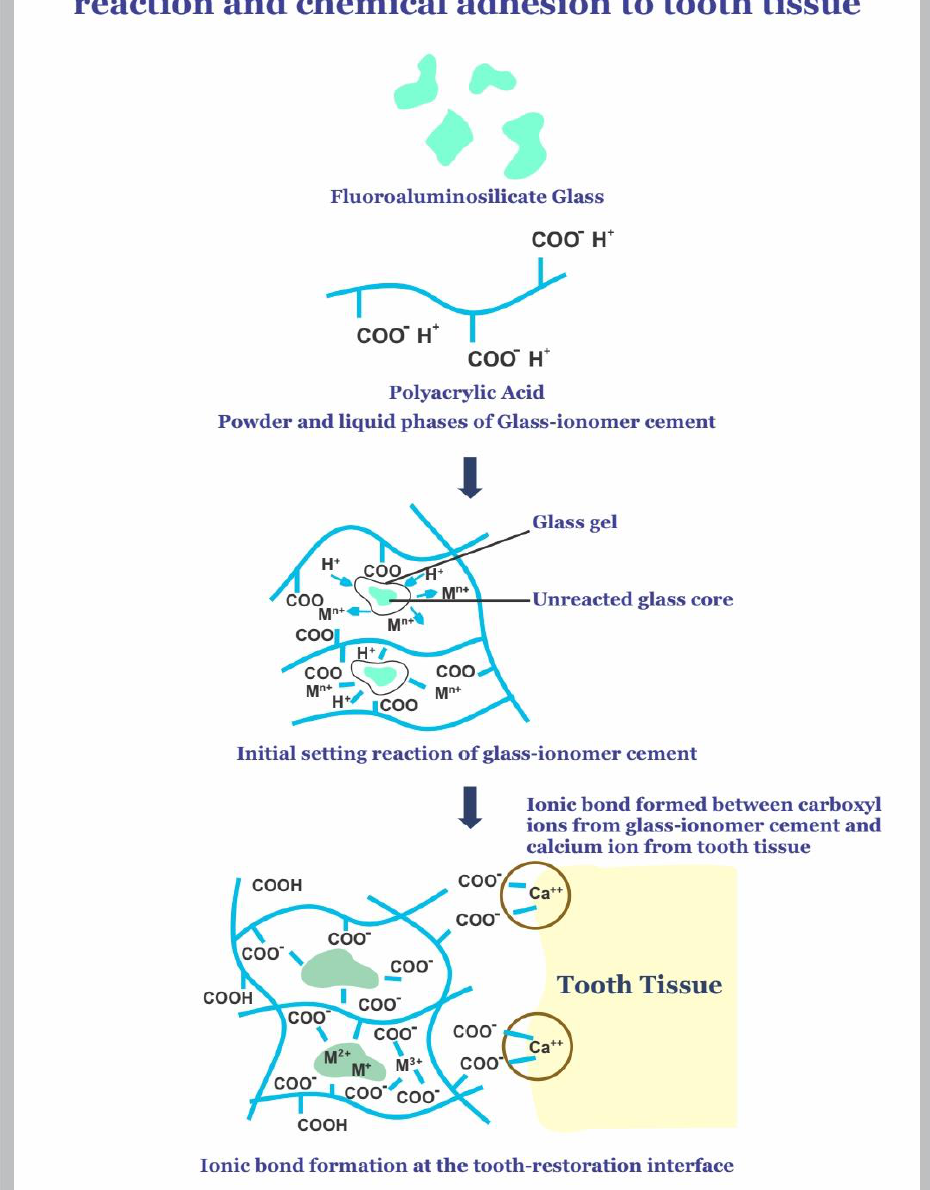
Figure 1. Chemical adhesion of glass-ionomer cement to tooth tissue. The adhesion process begins with the wetting of the hydrophilic tooth surface fol- lowing the placement of freshly mixed cement paste. The cement forms an intimate con- tact with the tooth, and this leads to adhesion through hydrogen bond formation between the free carboxyl groups of GIC and the bound water on the tooth surface [1,8]. These bonds are gradually replaced by true ionic bonds formed between calcium ions in the tooth and the anionic carboxylate functional groups of the polyacid molecules of the